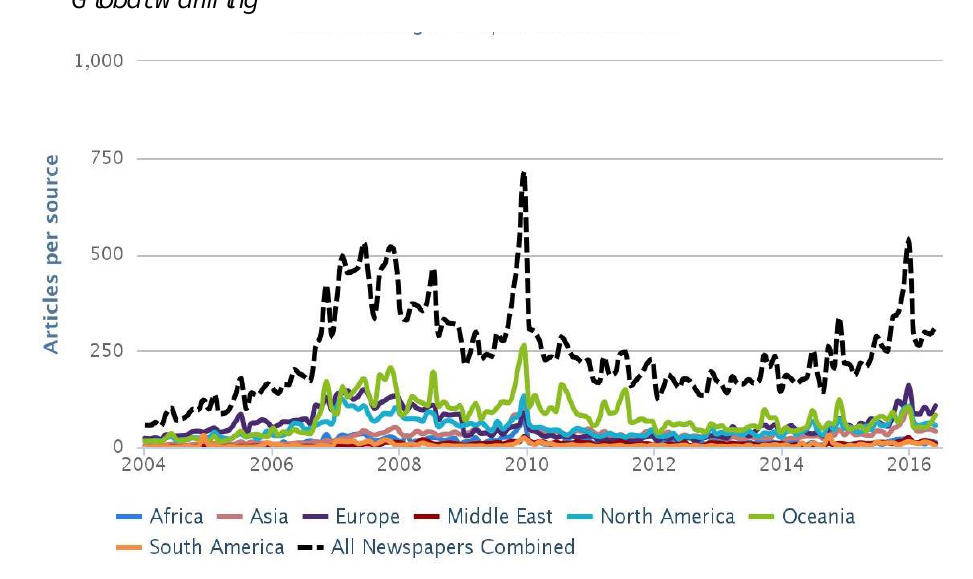
Source: Daly et al. (2016)